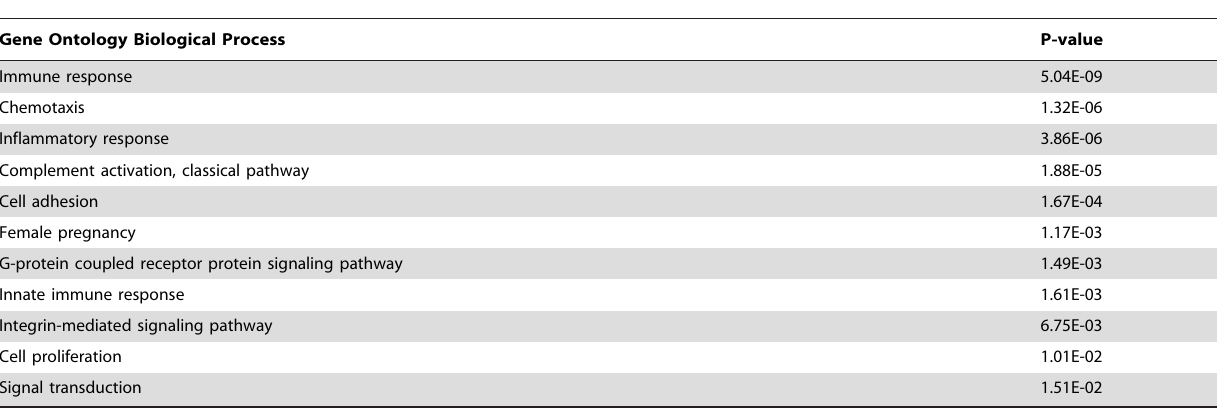
Table 1. GO term analysis of genes upregulated . 5-fold in hyperglycemic Akita mice compared to normoglycemic mice.